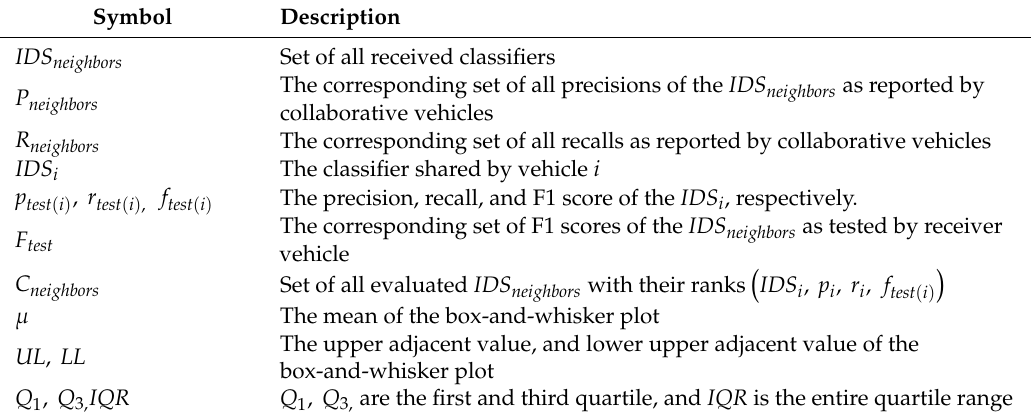
Table 2. Symbols